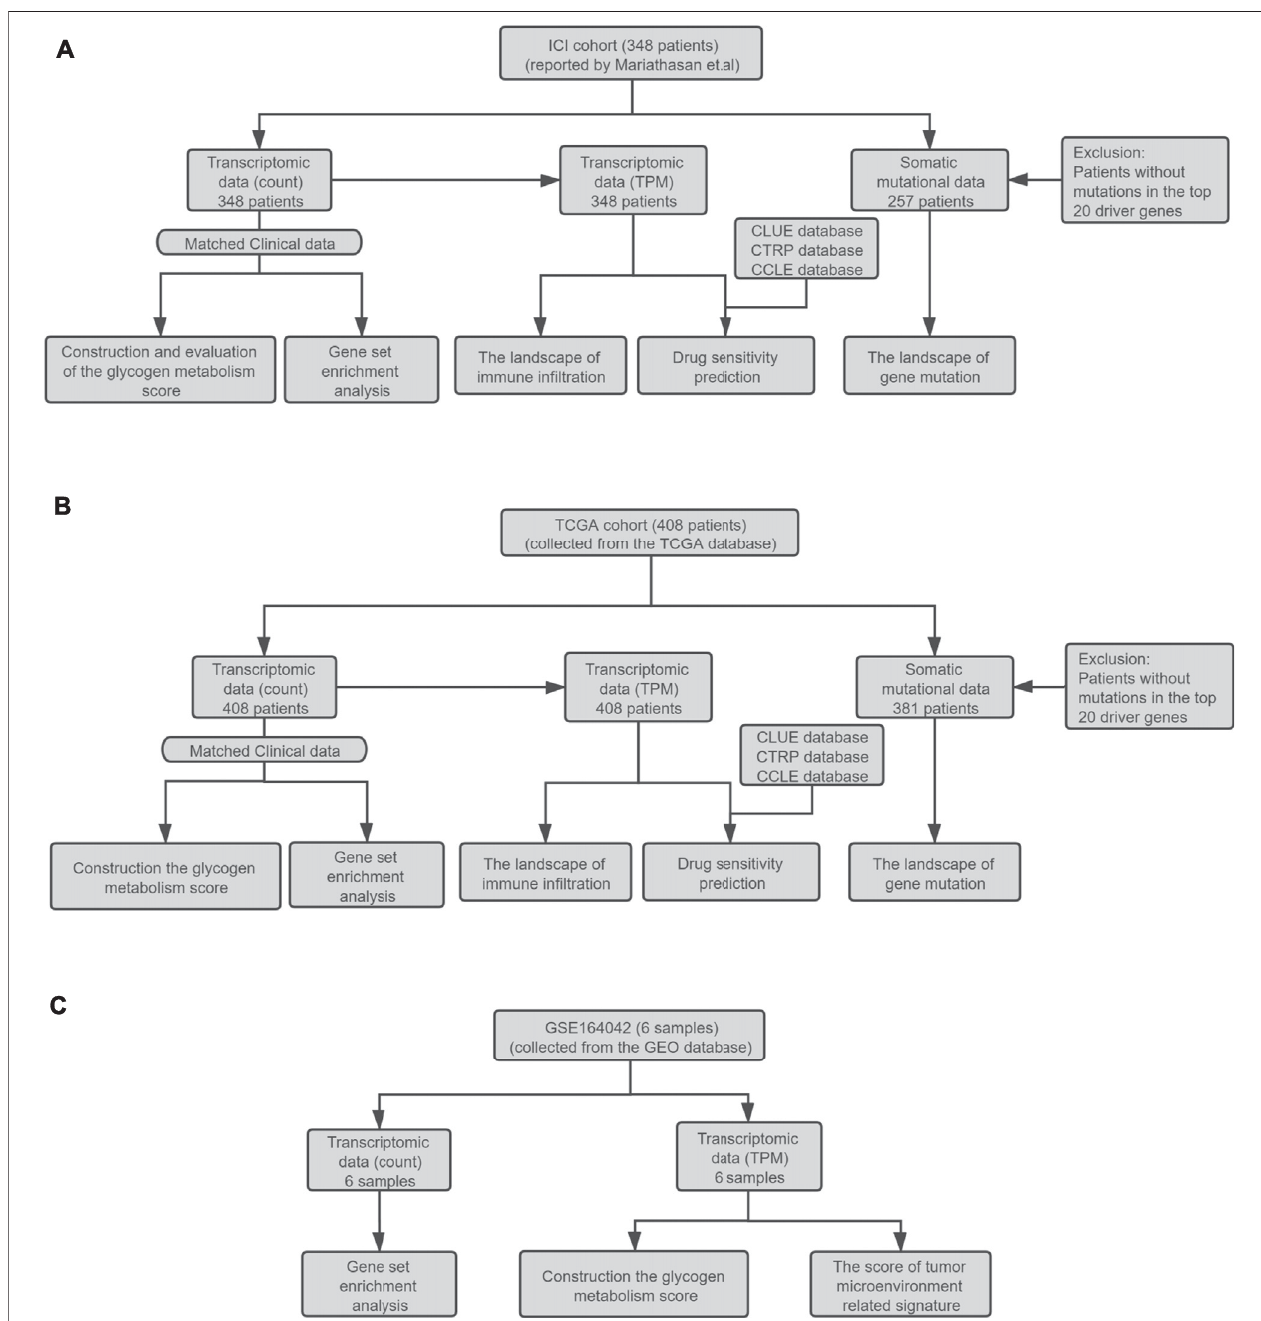
FIGURE 1 | (A) Establishment of the ICI cohort. The ICI cohort published by Mariathasan et al. included 348 UC patients who received the treatment of atezolizumab. (B) The establishment of the TCGA cohort. The TCGA cohort contained 408 bladder cancer patients collected from the TCGA database. The RNA-seq countdata,somaticmutationdata,andcorrespondingclinicaldataofthetwocohortswerethenusedtoevaluatetheprognosticvalueofGMS,explorethelandscapeof gene mutation and immune in fi ltration, GSEA analysis, and drug sensitivity prediction. (C) The collection of the high throughput sequencing data of GSE164042. This dataset contained sixsamplesfrom theUMUC3bladder carcinoma cell line. The RNA-seq data and corresponding grouping information ofthe sampleswere used to construct the GMS scores and tumor microenvironment related signature scores and perform GSEA analysis.